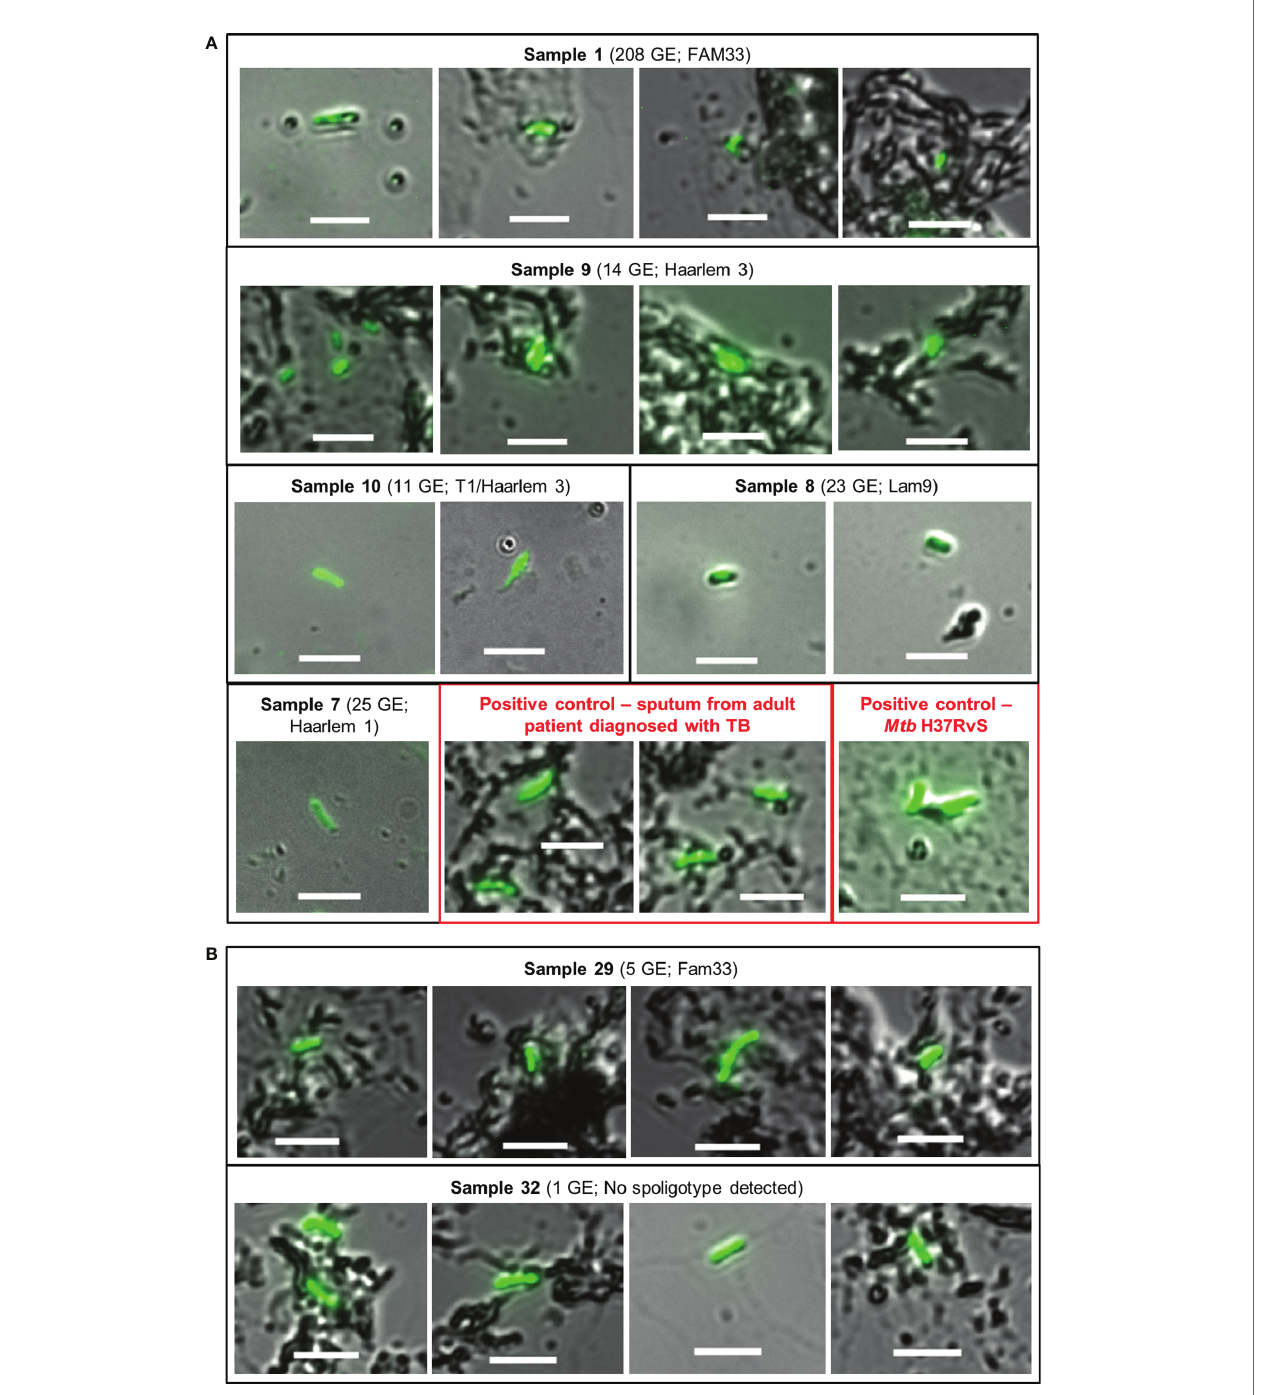
FIGURE 2 | Auramine smear microscopy from tongue swab samples. Ten microliters of each sample was aliquoted onto a microscope slide and stained with Auramine-O. (A) Representative images for positive samples from patients clinically diagnosed with TB; containing ≥ 10 genome equivalents as detected by qPCR and a spoligotype. Boxes in red represent positive controls from sputum (adult patient diagnosed with TB) and the lab strain of Mtb (H37Rv). (B) Samples from patients clinically diagnosed with LRTI, but their smears were detected as positive for Mtb . Sample 29 contained <10 genome equivalents of Mtb gDNA, ‘ scanty ’ acid-fast bacilli count and was assigned a strain-type by spoligotyping. Sample 32 was scored as ‘ 1+ ’ for acid-fast bacilli but negative for all other tests. In all cases, slides were viewed using a Zeiss Observer Z1 using two channels, i.e. DIC (bright- fi eld) and FITC (green) with exposure times of 100 – 150 and 3,000 ms, respectively. Scale bar represents 5